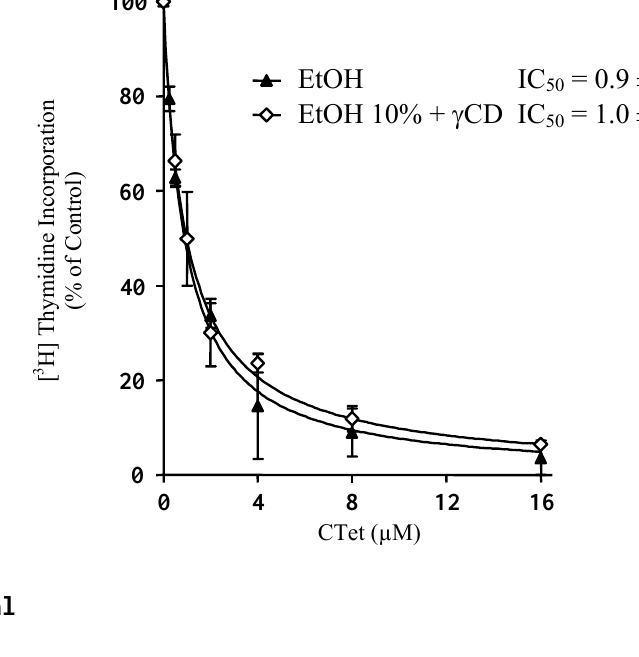
Figure 3. Effect of CTet formulated in aqueous solutions on DNA synthesis of MDA-MB- 231 breast cancer cell line. Cells were treated with various concentrations of CTet suspended in 10% EtOH with 160 mM γ -CD ( ◊ ) or pure EtOH ( ▲ ); during the last 5 h of treatment cells were pulsed with [ 3 H]thymidine, and the incorporation into DNA was determined (1.5 μ Ci). Data are expressed as percentage of cells treated with vehicle only and are means ± SEM of at least three experiments. A 10% ethanolic solution of γ -CD did not have any appreciable cytotoxicity in our